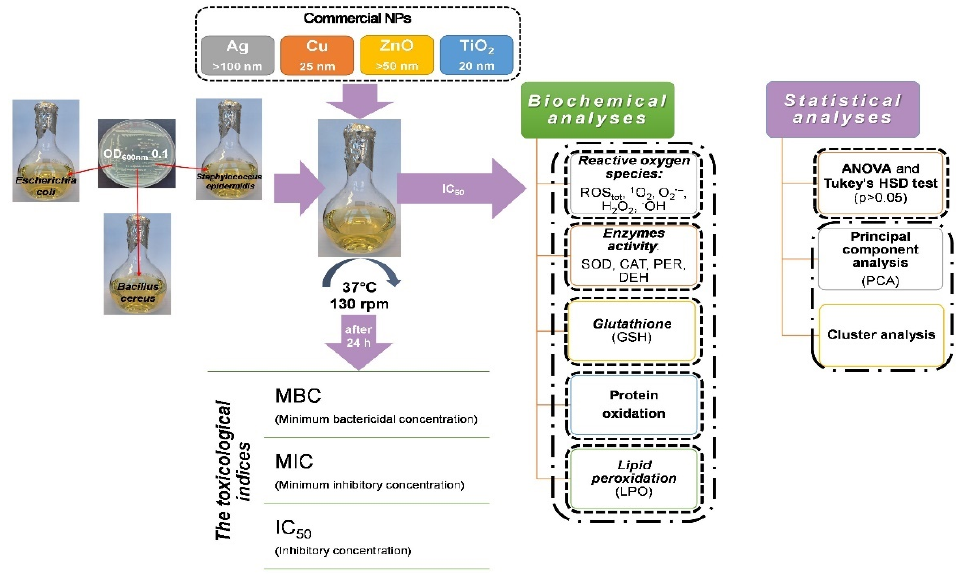
Figure 8. Scheme of experimental design.